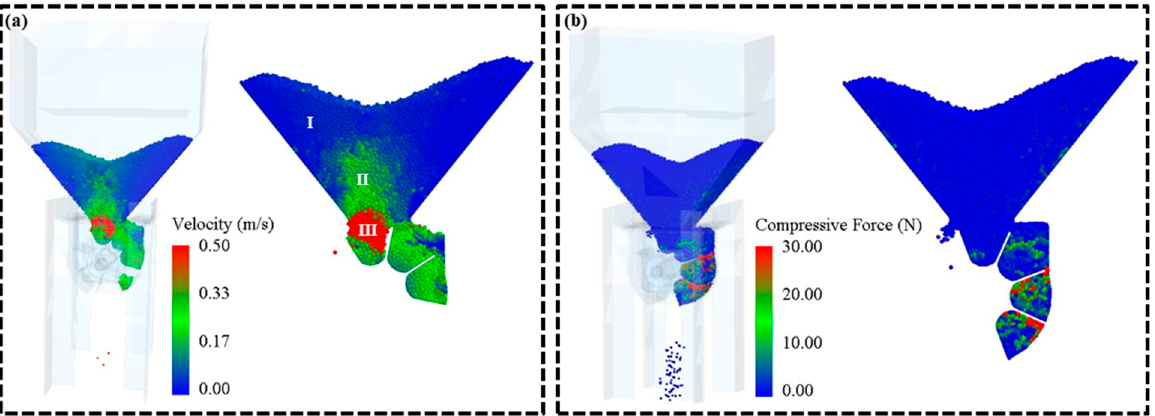
Figure 4. Particle velocity and compressive force analysis during pill filling and discharge process simulation: ( a ) the particle velocity analysis; ( b ) the particle compressive force